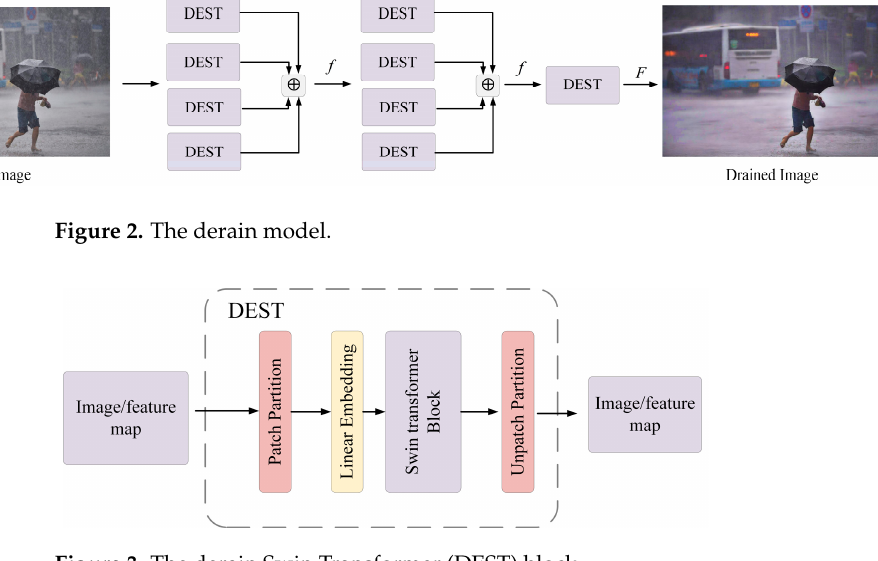
Figure 4. The architecture of the pedestrian and vehicle detection network.